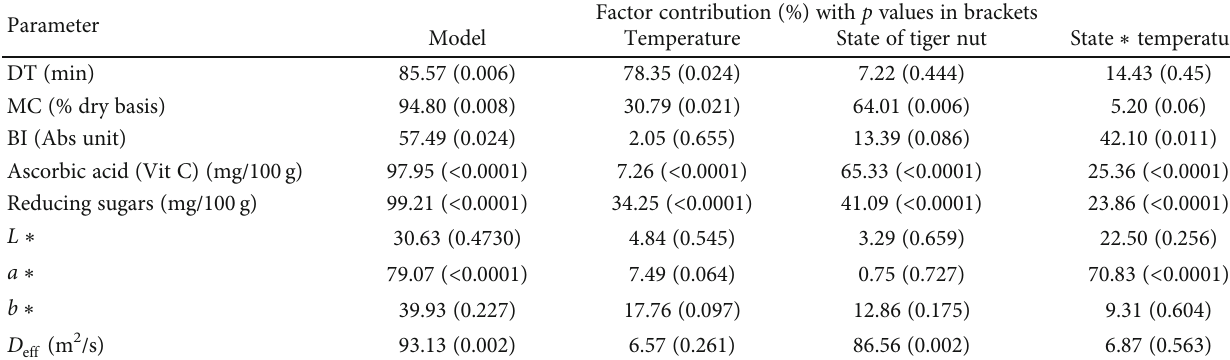
Table 4: Model and factor contribution to responses and their signi fi